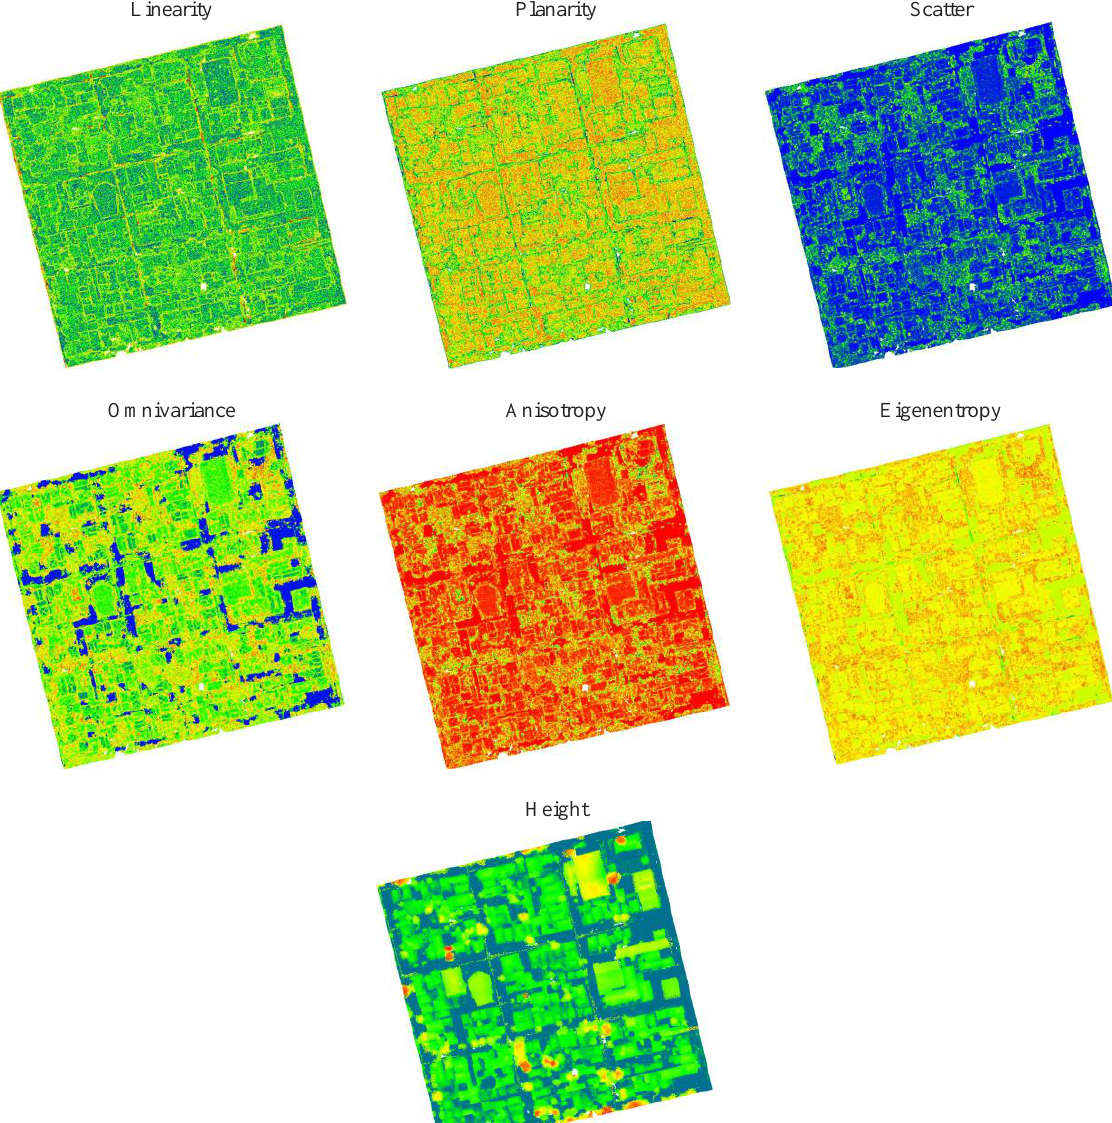
Figure 4. Geometric features estimated for the PPC.